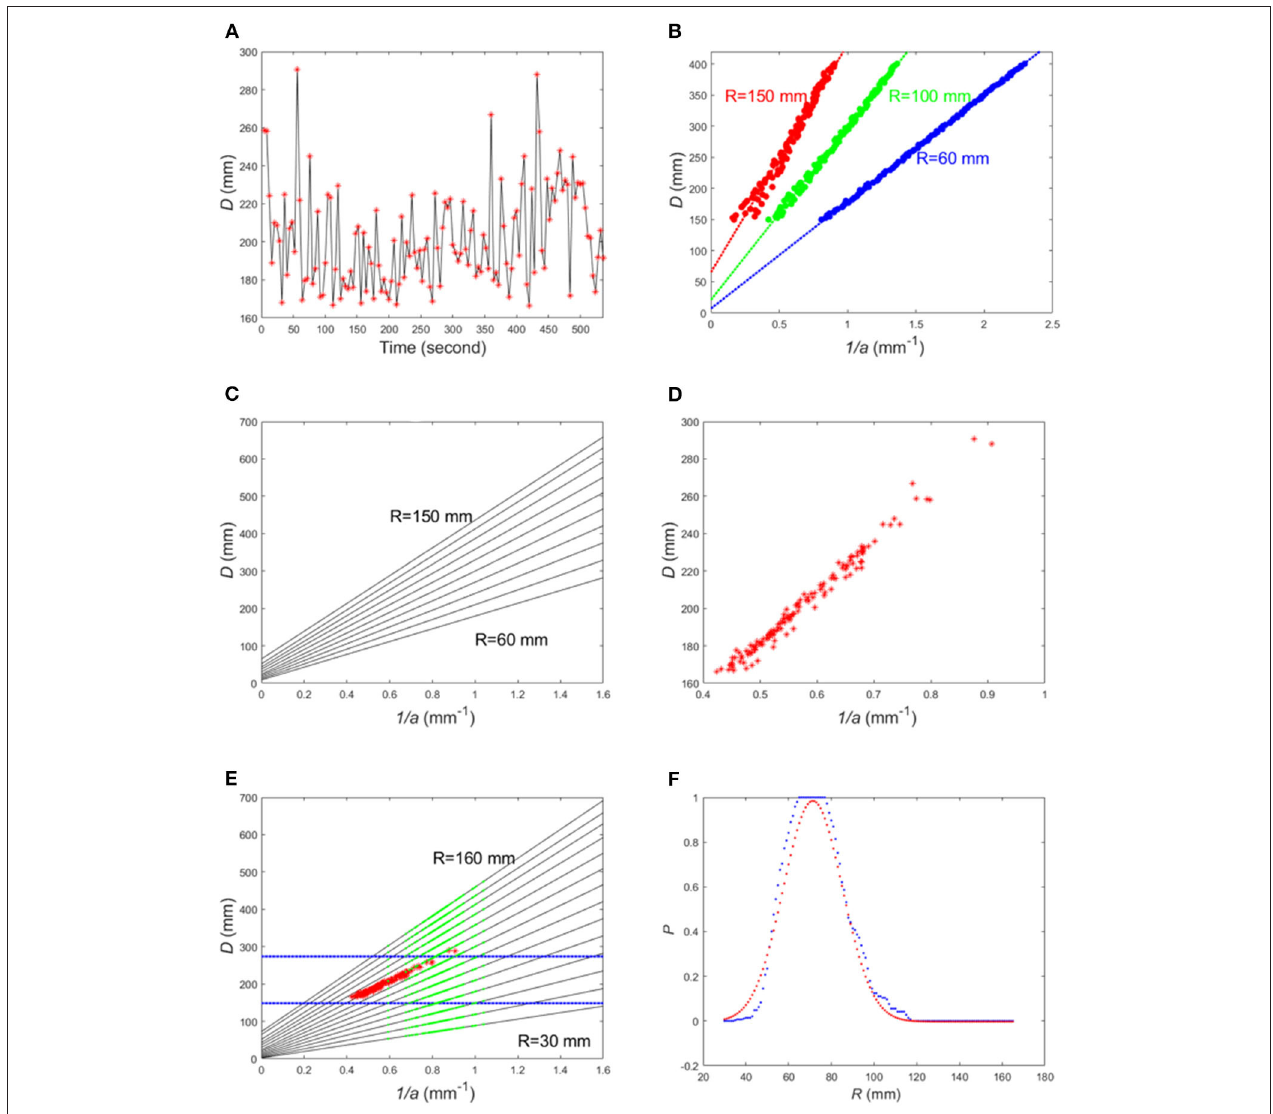
FIGURE 2 | (A) Plot of change of camera-to-plate distance (red dots) during an eating episode; (B) Simulated camera-to-plate distance vs. 1/ a using Equation (3); (C) A set of fitted curves for R = 60, 70, ··· ,150 mm; (D) Camera-to-plate distance D vs. 1/ a plot for the real data in (A) ; (E) The two dotted blue lines represent the distance range [ D l , D u ] obtained from calibrated data (red dots). The black lines represent the fitted lines for different plate radii. The green dots are the corresponding D i to each 1 / a i obtained from the image with unknown plate. (F) Plot of P and fitted Gaussian